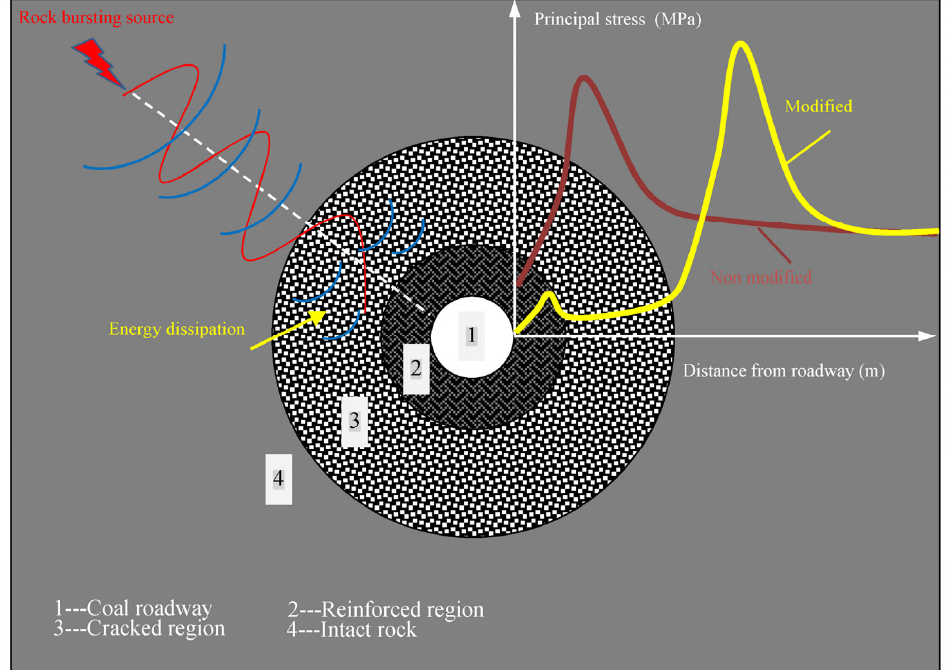
Figure 1. Generalized model of a modified coal roadway.